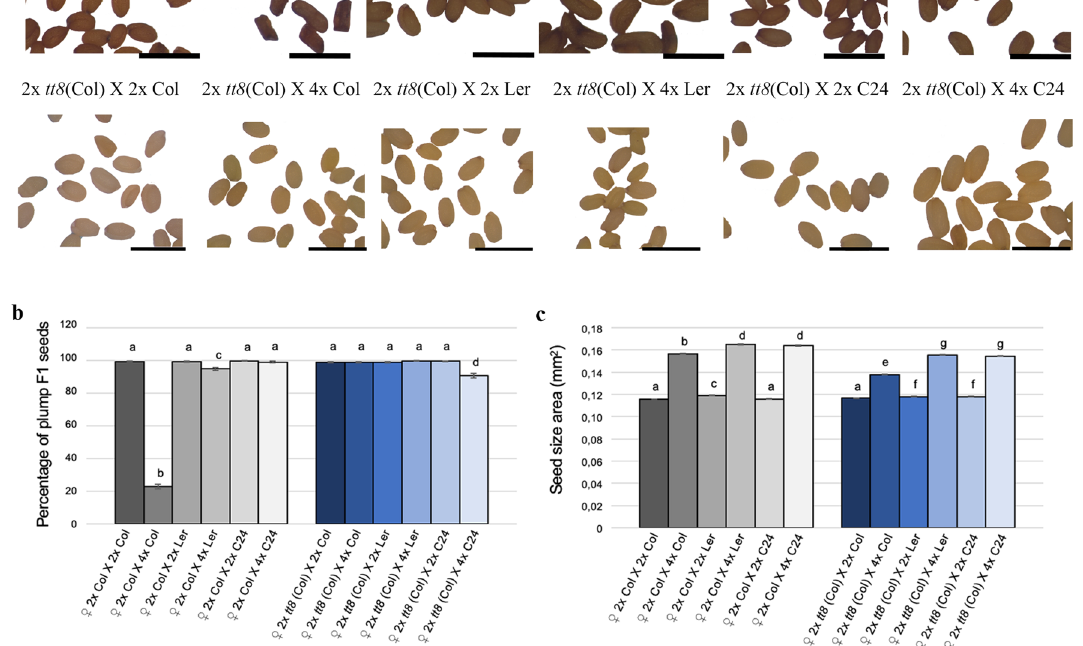
Figure 3. Interploidy crosses in wildtype and tt8 using three accessions of Arabidopsis thaliana (Col, Ler and C24). ( a ) Mature F1 seeds obtained crossing diploid Col and tt8 mutant with diploid or tetraploid pollen from three Arabidopsis thaliana . ( b ) Percentage of plump F1 seeds from interploidy crosses using different Arabidopsis accessions as pollen donors to pollinate diploid Col and tt8 mutants. Data presented as means ± standard error. Around 200 F1 seeds were analyzed for each cross. Pooled data of three independent assays performed with 3 replicates for each measurement. ( c ) Seed size of F1 seeds resulting from interploidy crosses using three accessions of Arabidopsis pollen donors to pollinate diploid Col and 2 × tt8 (Col) mutants. Data is presented as means ± standard error. Pooled data of three independent assays performed with 3 replicates for each treatment (200–300 seeds/each). tt8 corresponds to tt8-6. One-way ANOVA followed by Tukey HSD test was used for analyzing significance. Crosses marked with the same lowercase letter display no statistical difference. Scales: 1 mm